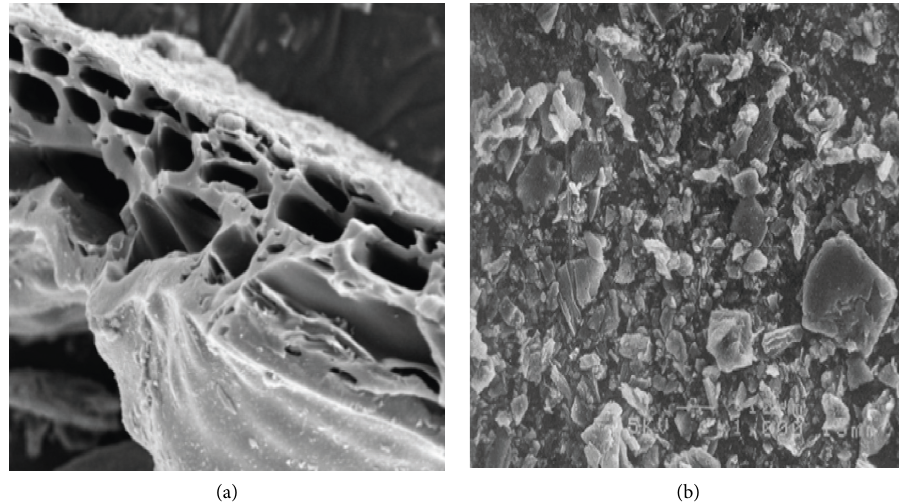
Figure 11: SEM image of RHA: (a) Greek and (b)